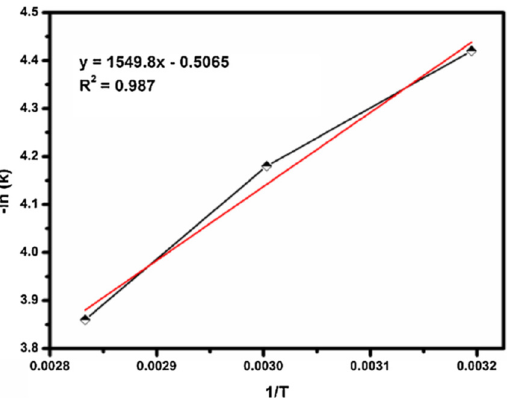
Figure 9. Plot of the inverse of temperature (1/T) versus root of the reaction rate constant -ln(k).[81].